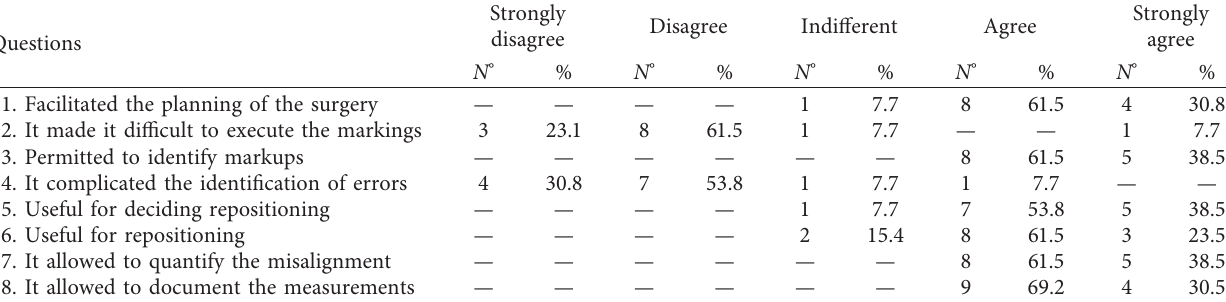
Table 2: Summary of responses from part 2 of the usability